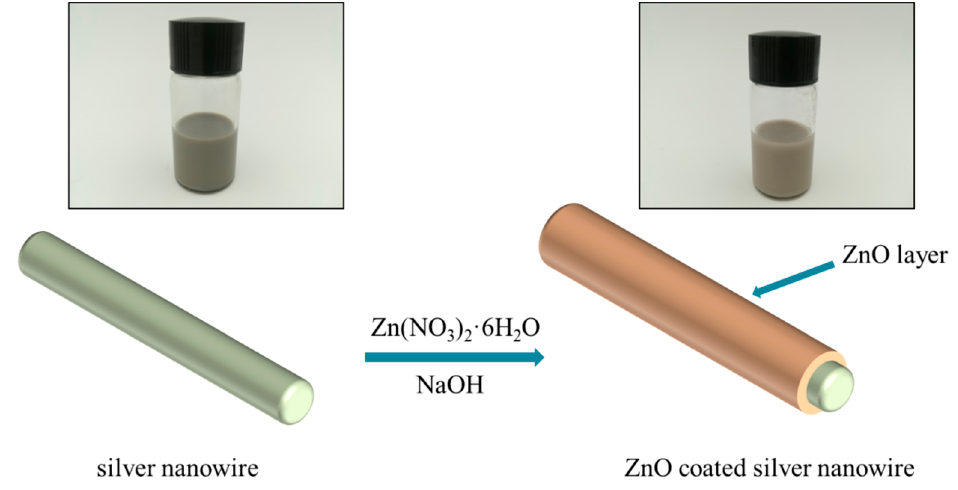
Figure 2. Schematic illustration of the preparation process of AgNW@ZnO filler.